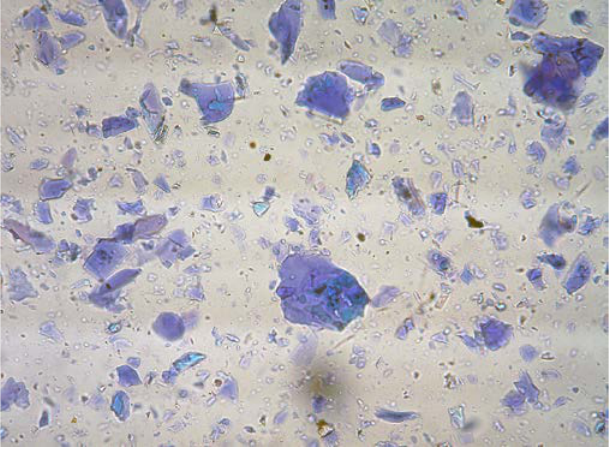
Figure 5. Han Purple. A modern pigment preparation supplied by Kremer Pigmente. PPL, 400×, field of view 0.25 mm. Photomicrograph by Ruth Siddall.